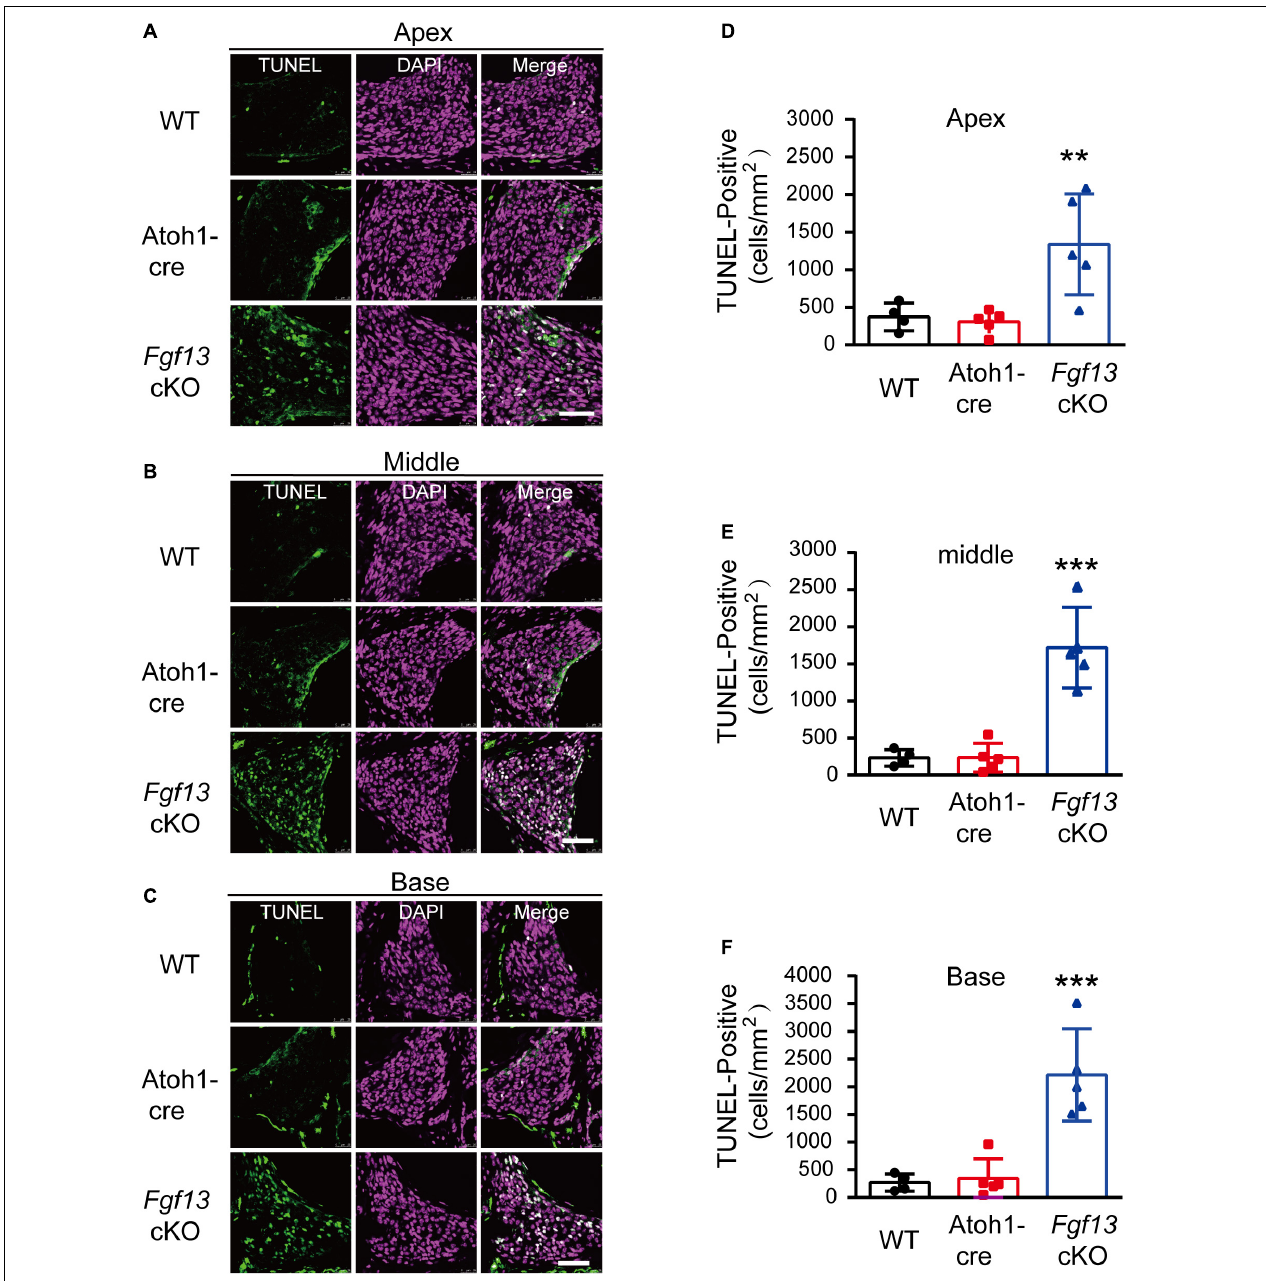
FIGURE 7 | Fgf13 cKO mice show accelerated SGNs apoptosis detected by TUNEL staining. (A–C) TUNEL staining of cochlea in WT, Atoh1-cre and Fgf13 cKO mice. Scale bar = 50 µ m. (D–F) Quantitative analysis of TUNEL-positive cells in apex (D) , middle (E) and base (F) . n = 4/WT (3 males, 1 females); n = 5/Atoh1-cre and Fgf13 cKO (3 males, 2 females). ** P < 0.01, *** P < 0.001 compared to controls as determined by One-Way ANOVA